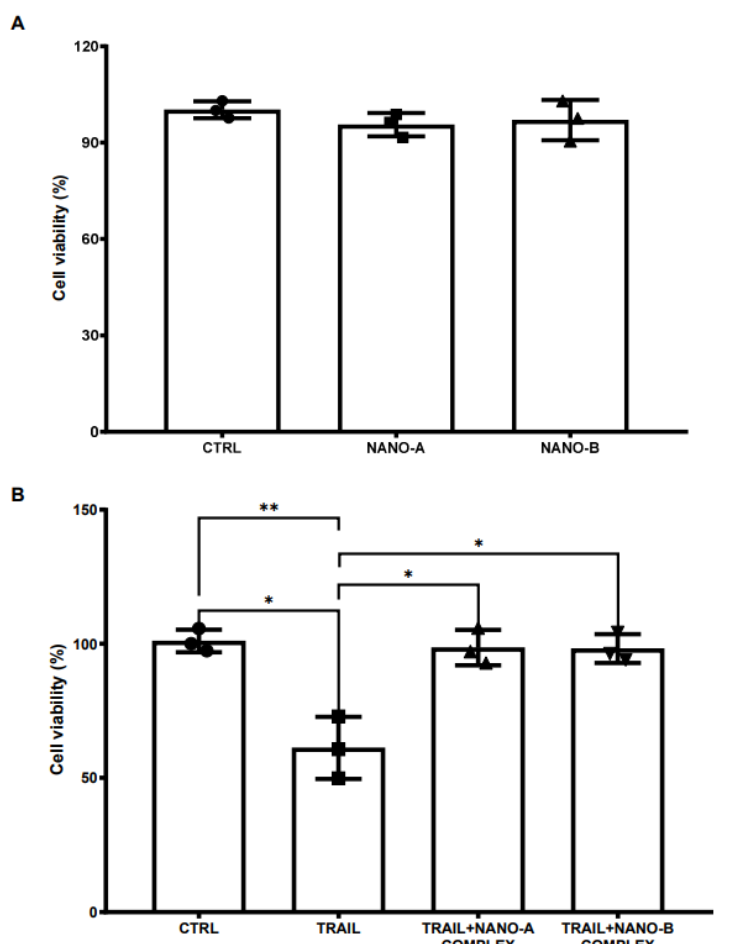
Figure 3. RAW 264.7 cell viability (%) after 72 h of treatment with empty nanoparticles (NANO-A and NANO-B) ( A ). In ( B ) is depicted the cell viability percentage after treatment with TRAIL (100 ng/mL) alone or in combination with either nanoparticles complexed with the anti-TRAIL antibody (NANO-A or NANO-B complexes). Data are expressed as mean ± SD. One-way ANOVA followed by the Fisher’s LSD test were used for statistical analysis. * p < 0.05 or ** p < 0.01.